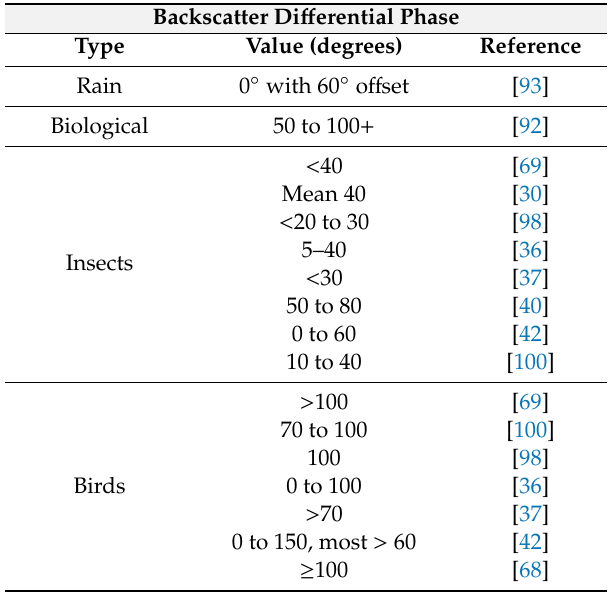
Table A5. Examples of backscatter di ff erential phase values for di ff erent types of